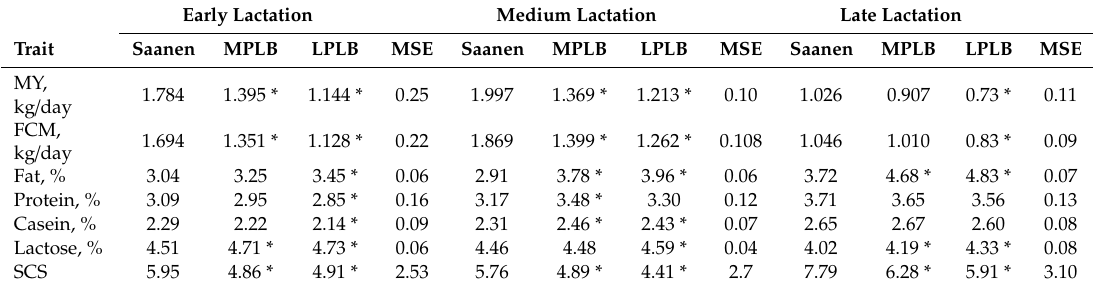
Table 2. Milk production traits (least squares means and mean standard error) of the Saanen breed compared with Mediterranean medium production level breeds (MPLB: Maltese and Jonica breeds) and low production level breeds (LPLB: Rossa Mediterranea, Girgentana, and Garganica breeds) during early lactation (2–4 weeks in milking), medium lactation (5–10 weeks in milking), and late lactation (11–30 weeks in milking). Early Lactation Medium Lactation Late